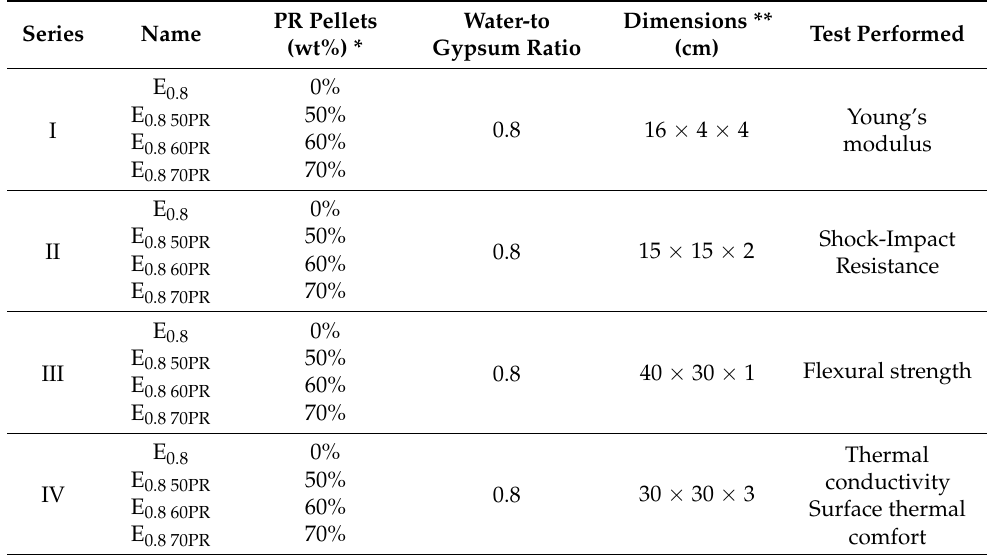
Table 1. Name of samples, composition, dimensions, and test performed.